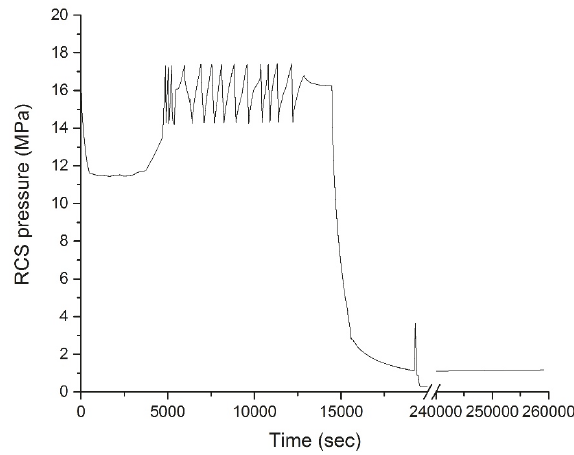
Table 2: The accident sequence of base case.